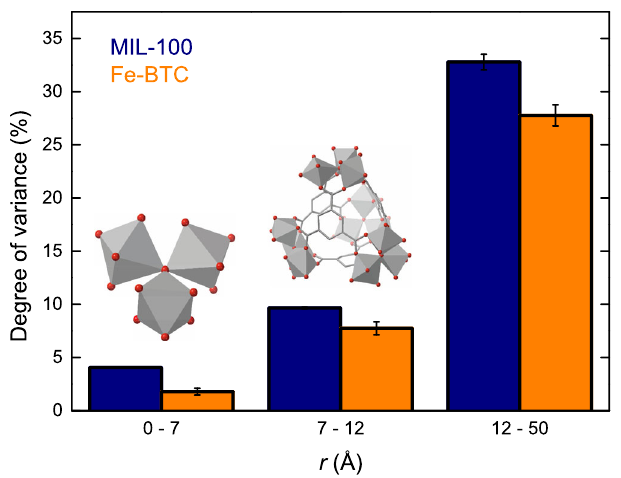
Fig. 7 Hierarchical structural analysis. The degree of variance captured by the distortion principal components in MIL-100 (navy) and Fe-BTC (orange) upon structural collapse to form a m MIL-100 and a m Fe-BTC, respectively, in the 0 – 7 Å (trimer unit), 7 – 12 Å (tetrahedral assembly), and 12 – 50 Å (extended structure) regions. Uncertainties represent the variance associated with the discarded principal components. Inset fi gures show the structure of the trimer unit (left) and tetrahedral assembly